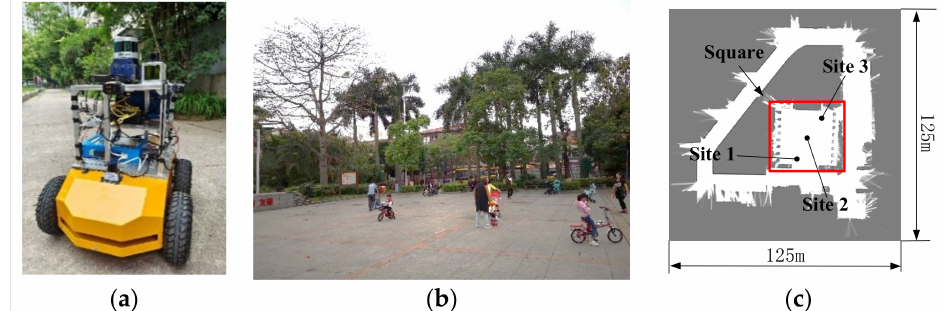
Figure 2. Experimental scene and platform. ( a ) Platform prototype. ( b ) Dynamic scene. ( c ) Grid map of the